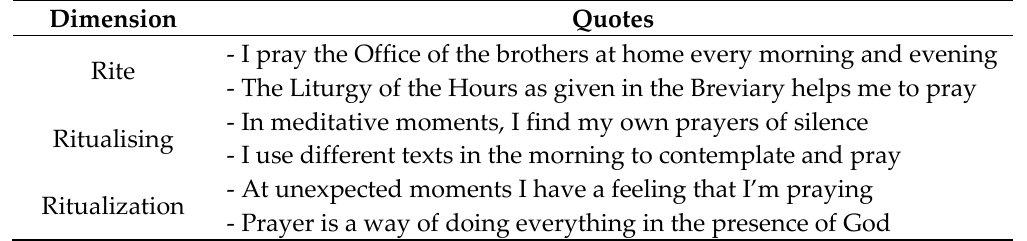
Table 4. Dimensions of prayer—monastic context.